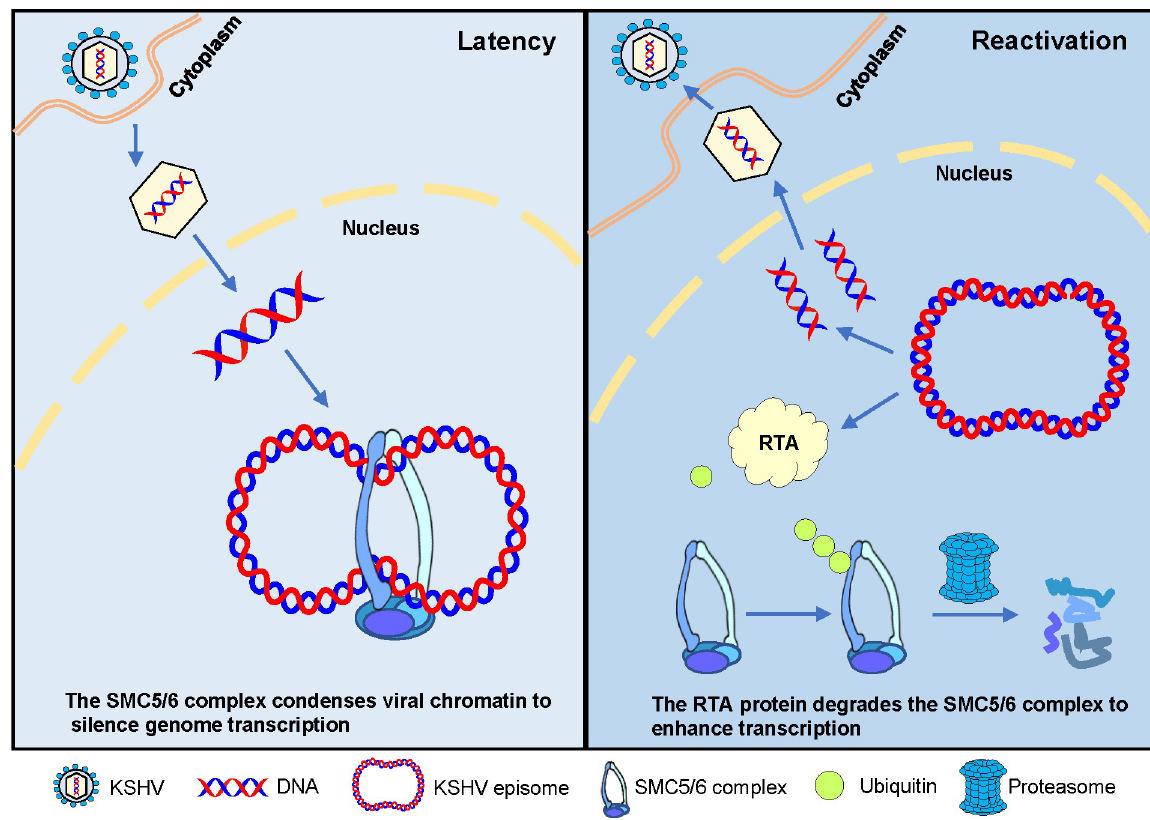
Fig 9. Model for the role of the SMC5/6 complex in regulating KSHV latency and reactivation. During KSHV latent replication, the host protein SMC5/6 complex binds to the KSHV episome and condenses viral chromatin, creating a repressive chromatin structure to silence genome transcription. During KSHV lytic replication, the RTA protein interacts with the SMC5/6 complex and induces ubiquitin-proteasome- mediated degradation of the SMC5/6